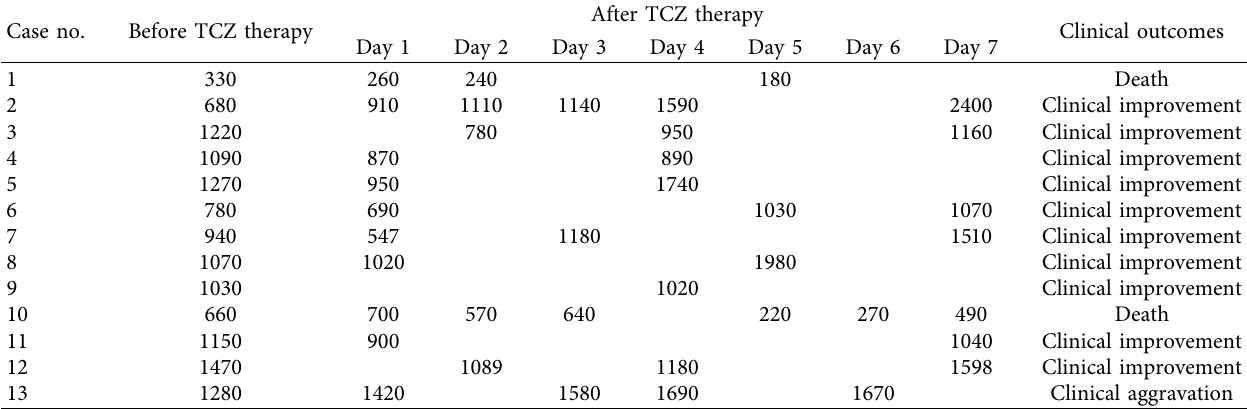
The normal value of CRP ranges from 0.00 to 10.00mg/L. Table 4: The lymphocyte counts of COVID-19 patients before and after TCZ treatment (/ μ L). Case